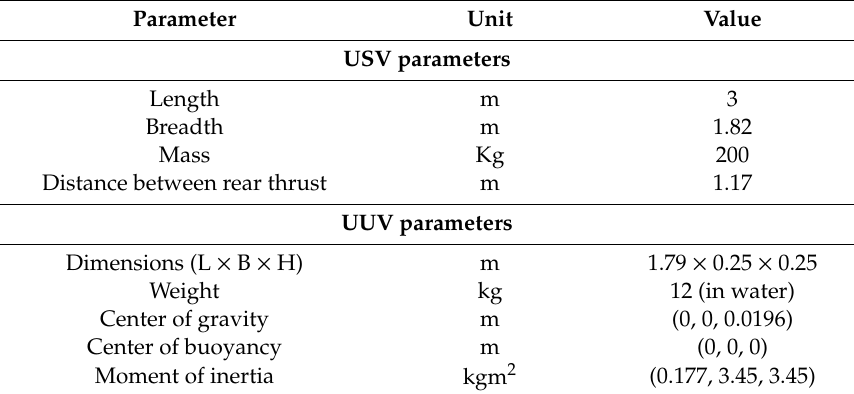
Table 4. The parameters for the